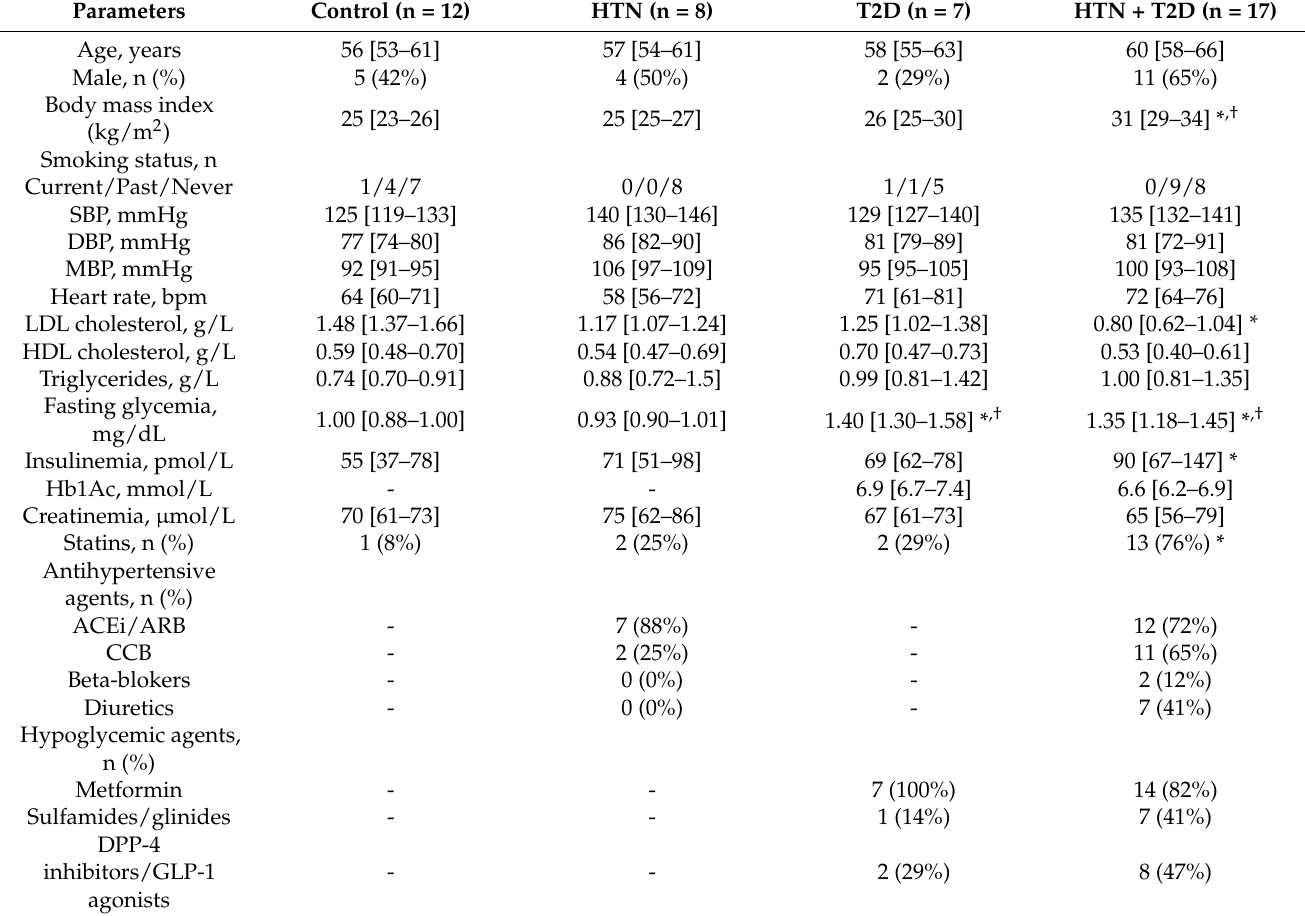
Table 2. Demographics and clinico-biological characteristics of the study